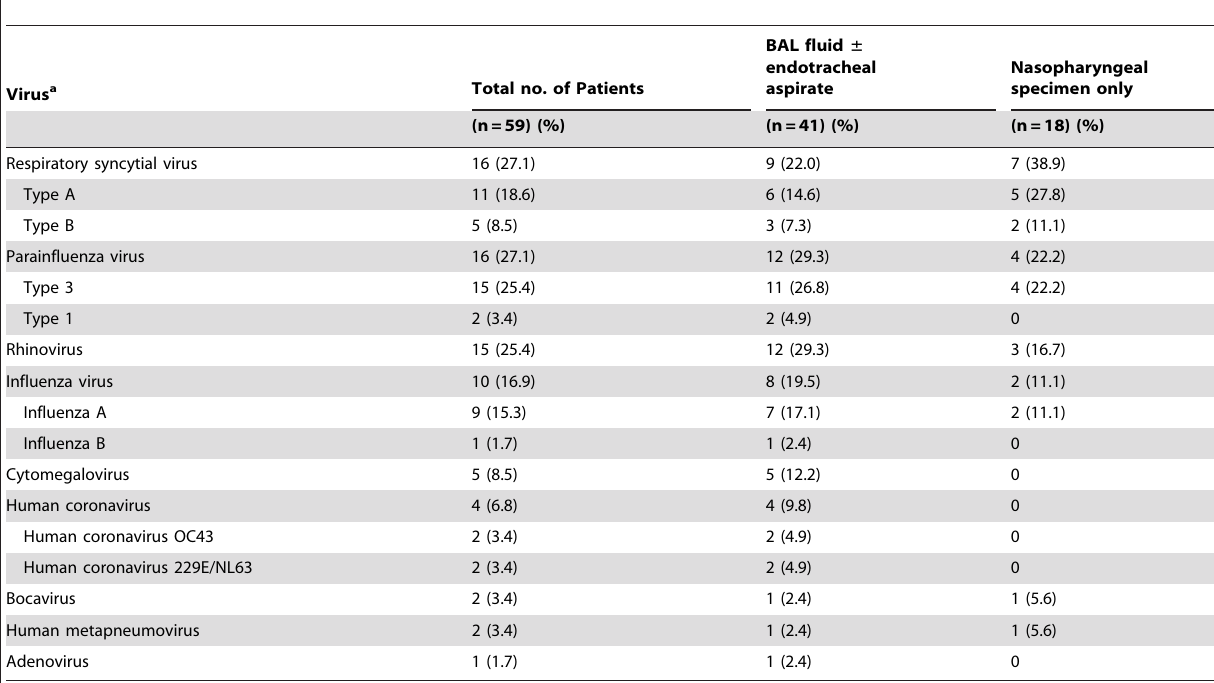
Table 3. Microbiological diagnosis of respiratory viruses in hospital-acquired